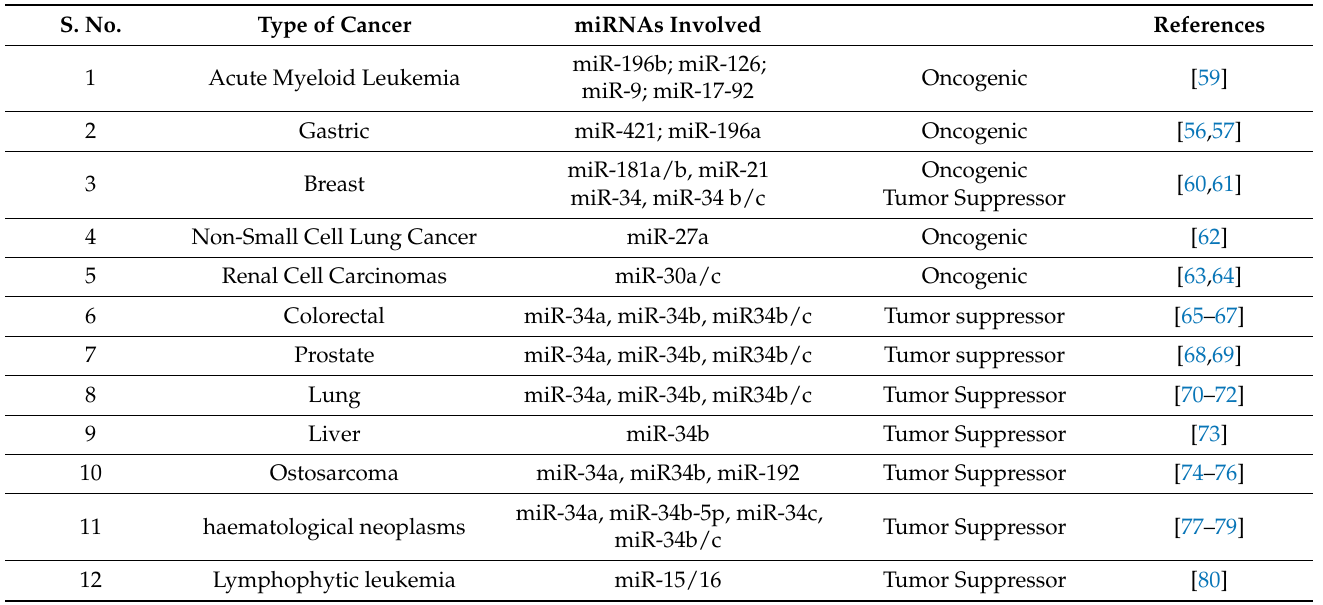
Table 1. Examples of oncogenic